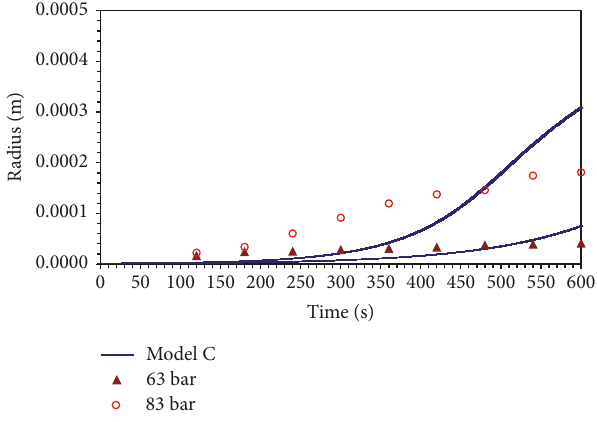
Figure 17: Model B versus experimental data for bubble growth at 70 ∘ C.